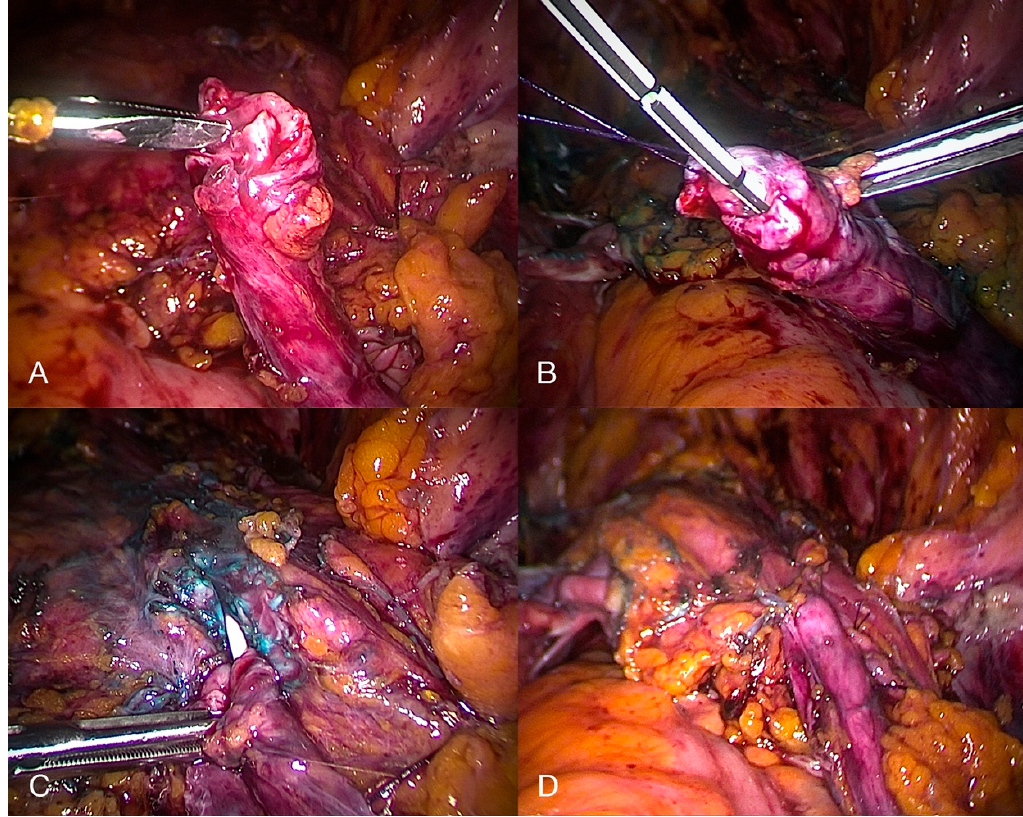
Figure 9. Laparoscopic depiction of a transected ureter ( A ) without stent and ( B ) with stent, followed by an ( C ) initial and ( D ) complete ureteroneocystostomy secondary to ureteral deep